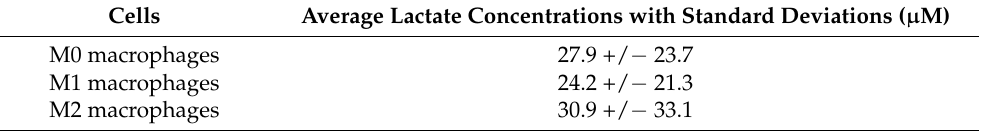
Table 2. Average lactate production +/ − standard deviations by differentiated and polarized macrophages not incubated with Alhydrogel ® , i.e., the serum-free medium control of M0, M1, and M2 macrophages, independently differentiated and polarized from nine donors.